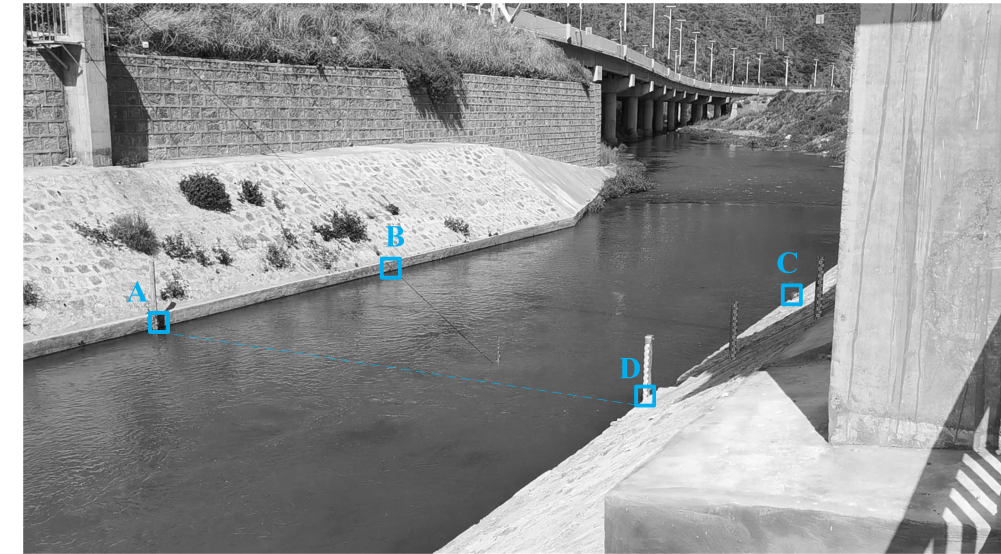
Figure 5. Open channel ground marking